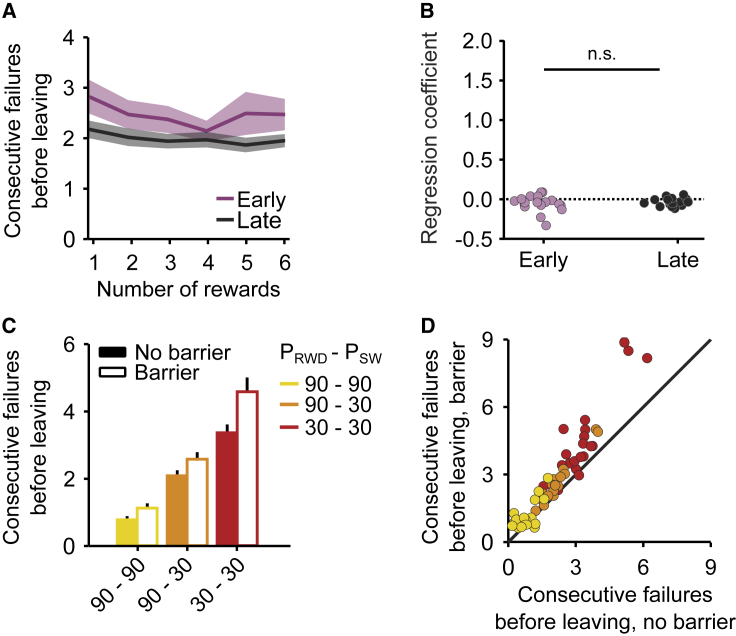
Humans Perform Optimal Inference and Tune Behavior to Task Parameters(A) The number of rewards has little effect on the probability of leaving during both early (purple) and late (black) training. Solid line and shaded area represent mean and across animals. Solid line and shaded area represent mean and SEM across animals.(B) Number of consecutive failures as a function of reward number for human in early versus late part of training. Unlike mice, humans learn the statistics of the environment extremely quickly: slope coefficient is similar (and around 0) in both early and late trials: likelihood ratio test on linear mixed-effect model ConsecutiveFailures~1+RewardNumber+Early+RewardNumber&Early+(1|SubjectID) versus a null model with no interaction: p = 0.45, n = 20 subjects.(C) Consecutive failures before leaving as a function of the environment statistics and barrier condition. Error bars represent SEM across subjects.(D) Consecutive failures before leaving split by subject and environment statistics, barrier versus no barrier.See also Video S2.Video S2. Human Foraging Task, Related to Figure 2A human participant showcasing correct and incorrect transitions, touch screen use, as well as easy, medium, and hard protocols in the hidden-state foraging task.